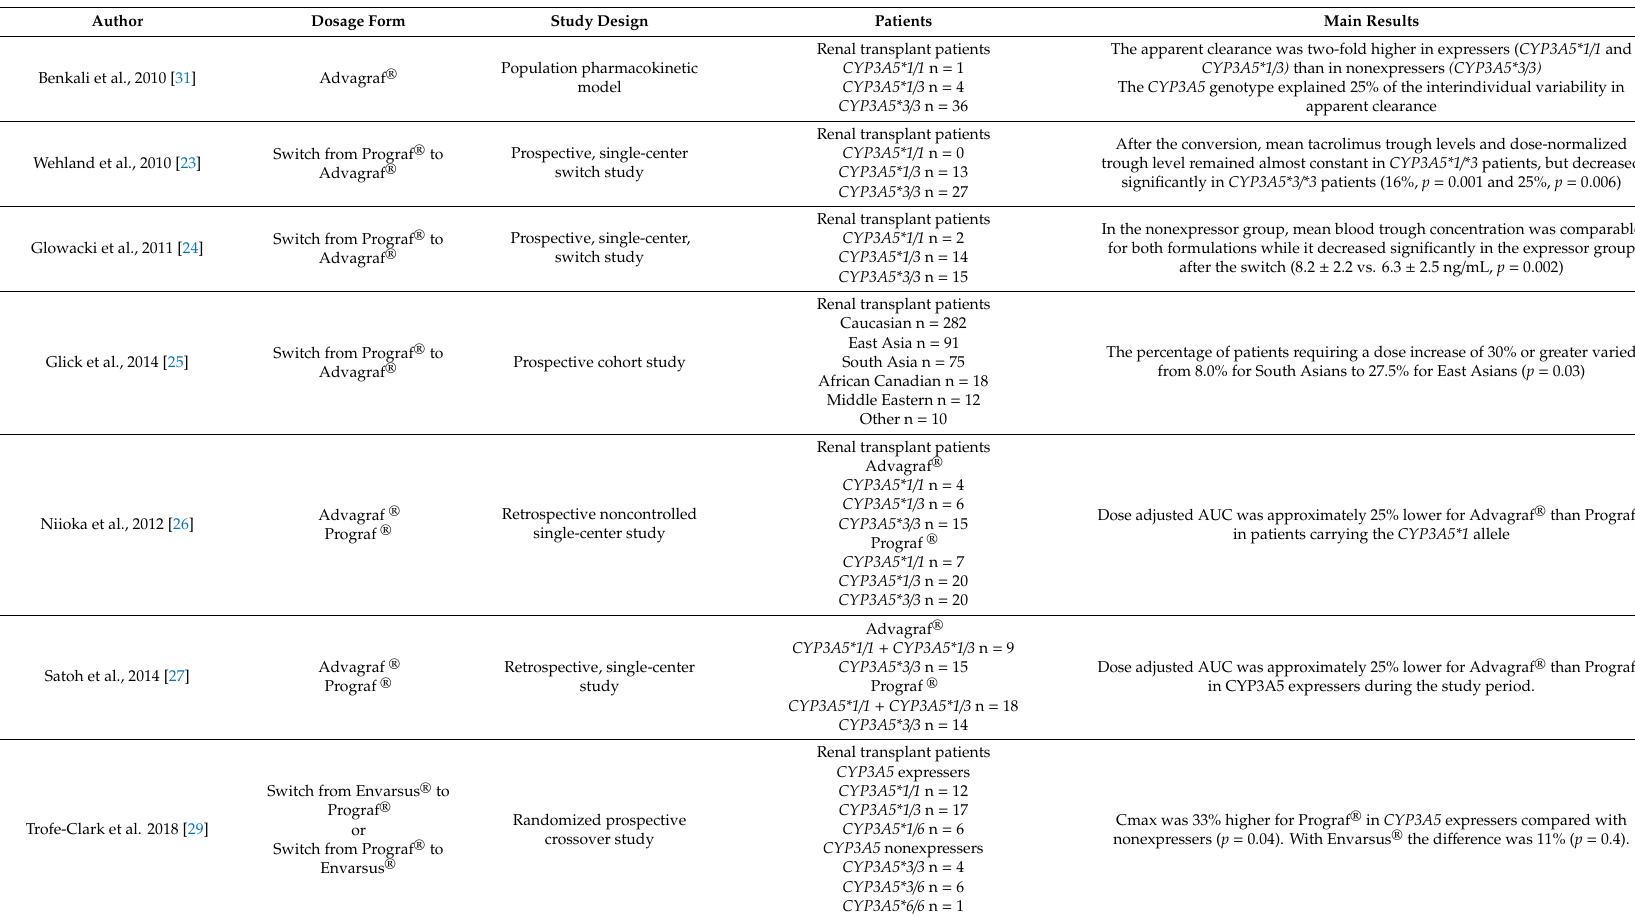
Table 1. E ff ect of CYP3A5 genotype on exposure to tacrolimus when switching from one formulation to